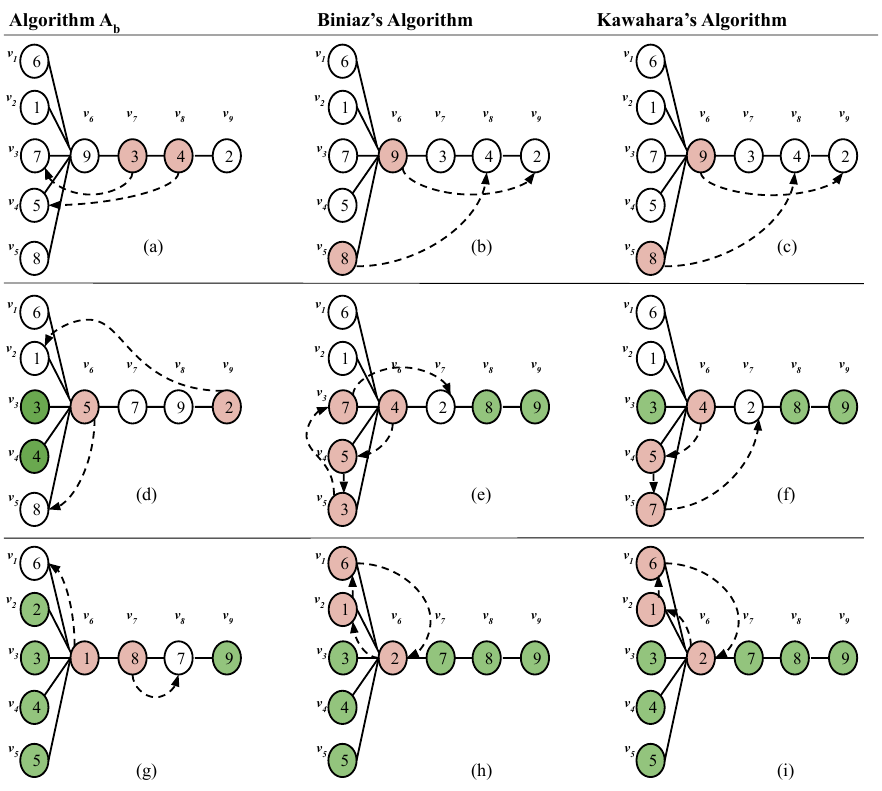
Figure 3. Comparison of algorithm A b with Biniaz’s and Kawahara’s algorithms. ( a ) S min = 3, Swaps = 2; S min = 4, Swaps = 3. ( b ) Maximum valued path token( P max ) = 9, Swaps = 3; P max = 8, Swaps = 3. ( c ) Maximum valued token( T max ) = 9, Swaps = 3; T max = 8, Star tokens = {3}, Swaps = 4. ( d ) S min = 5, Swaps = 1; S min = 2, Swaps = 4. ( e ) P max = 7, centered star chain = {4,5,3,7}, Swaps = 4. ( f ) T max = 7, Star tokens = {4,5}, Swaps = 3. ( g ) S min = 1, Swaps = 1; P max = 8, Swaps = 1, Total Swaps = 12. ( h ) P max = 6, centered star chain = {2,1,6}, Swaps = 2, Total Swaps = 12. ( i ) T max = 6, Star tokens = {2,1}, Swaps = 2, Total Swaps =